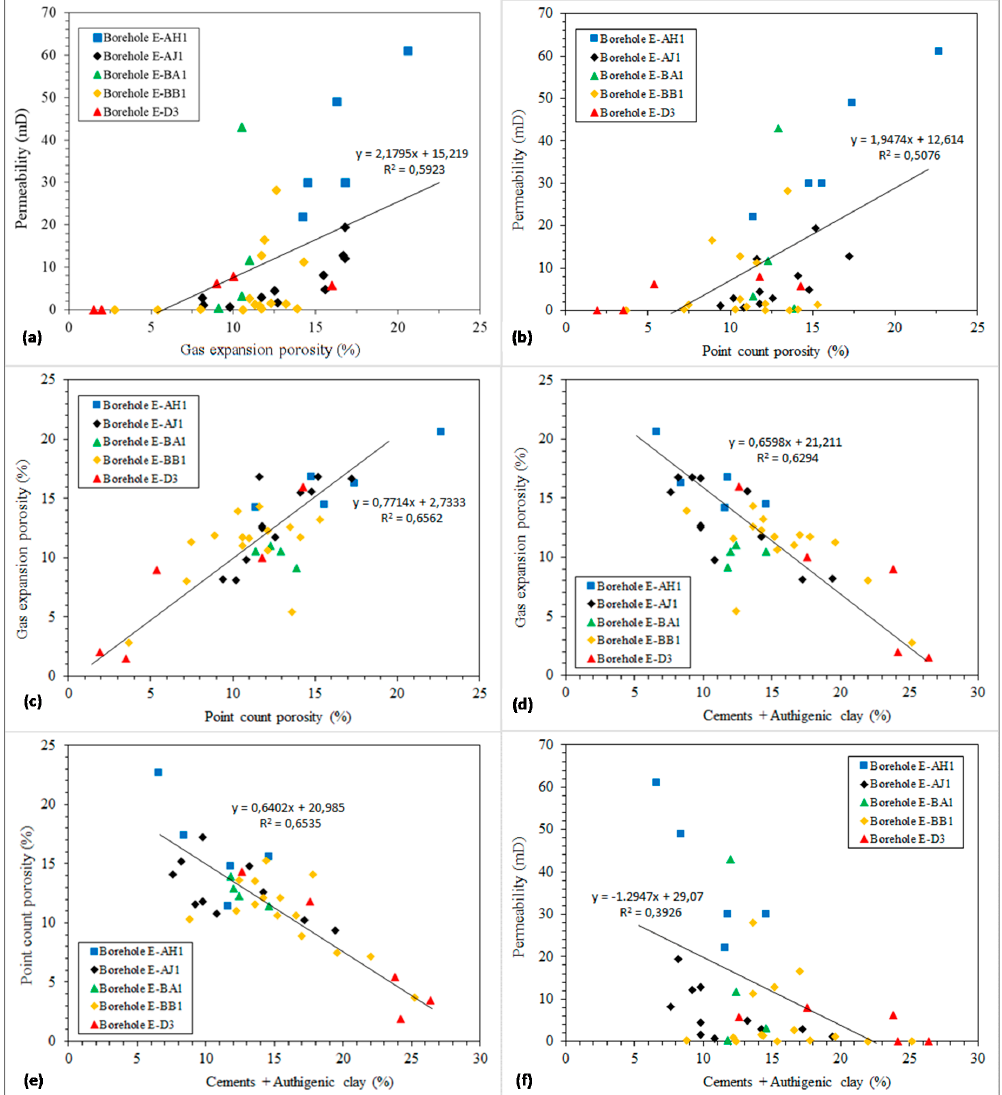
Figure 10. Scatter plots of the reservoir property data of the Bredasdorp sandstones showing the relationship between visual point counted porosity, gas expansion porosity, permeability, and cements plus authigenic clays: ( a ) Gas expansion porosity versus permeability; ( b ) Point counted porosity against permeability; ( c ) Point counted porosity versus gas expansion porosity; ( d ) Cements + authigenic clays against gas expansion porosity; ( e ) Cements + authigenic clays versus point counted porosity; ( f ) Cements + authigenic clays against permeability.